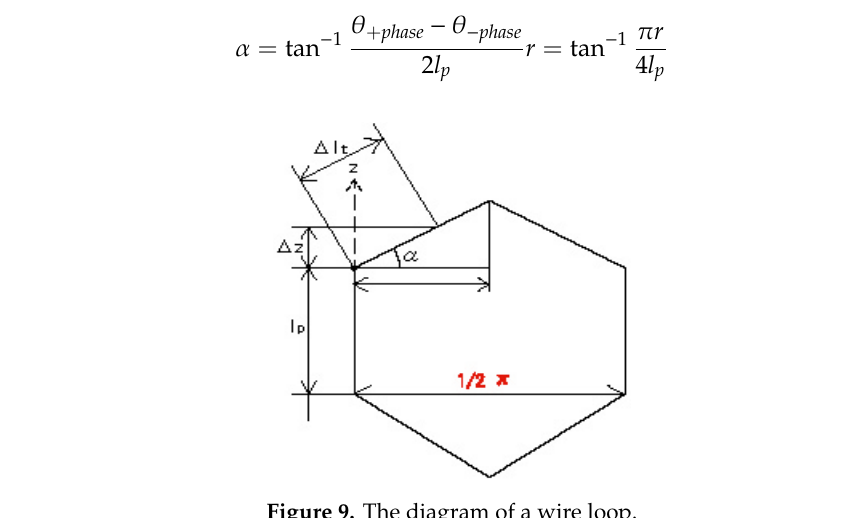
Figure 9. The diagram of a wire loop.